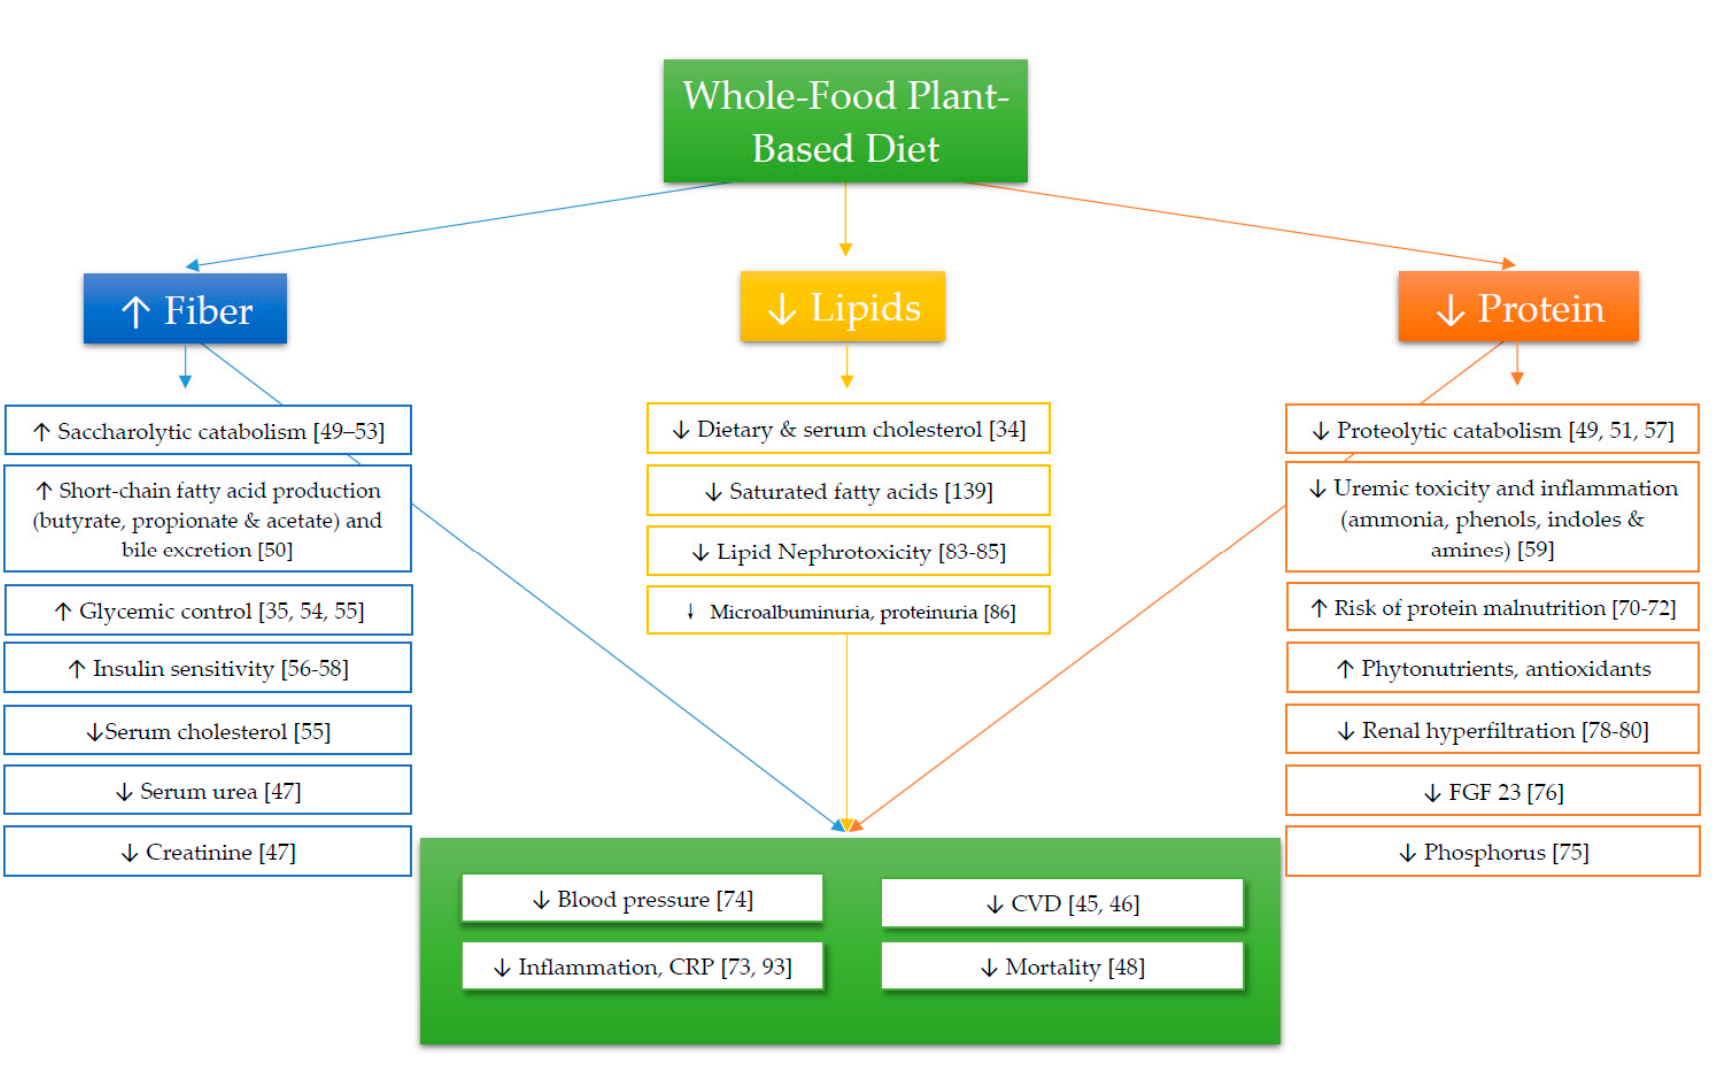
ff ects of a whole food plant-based Figure 1. Cited effects of a whole food plant-based diet. Figure 1. Cited e